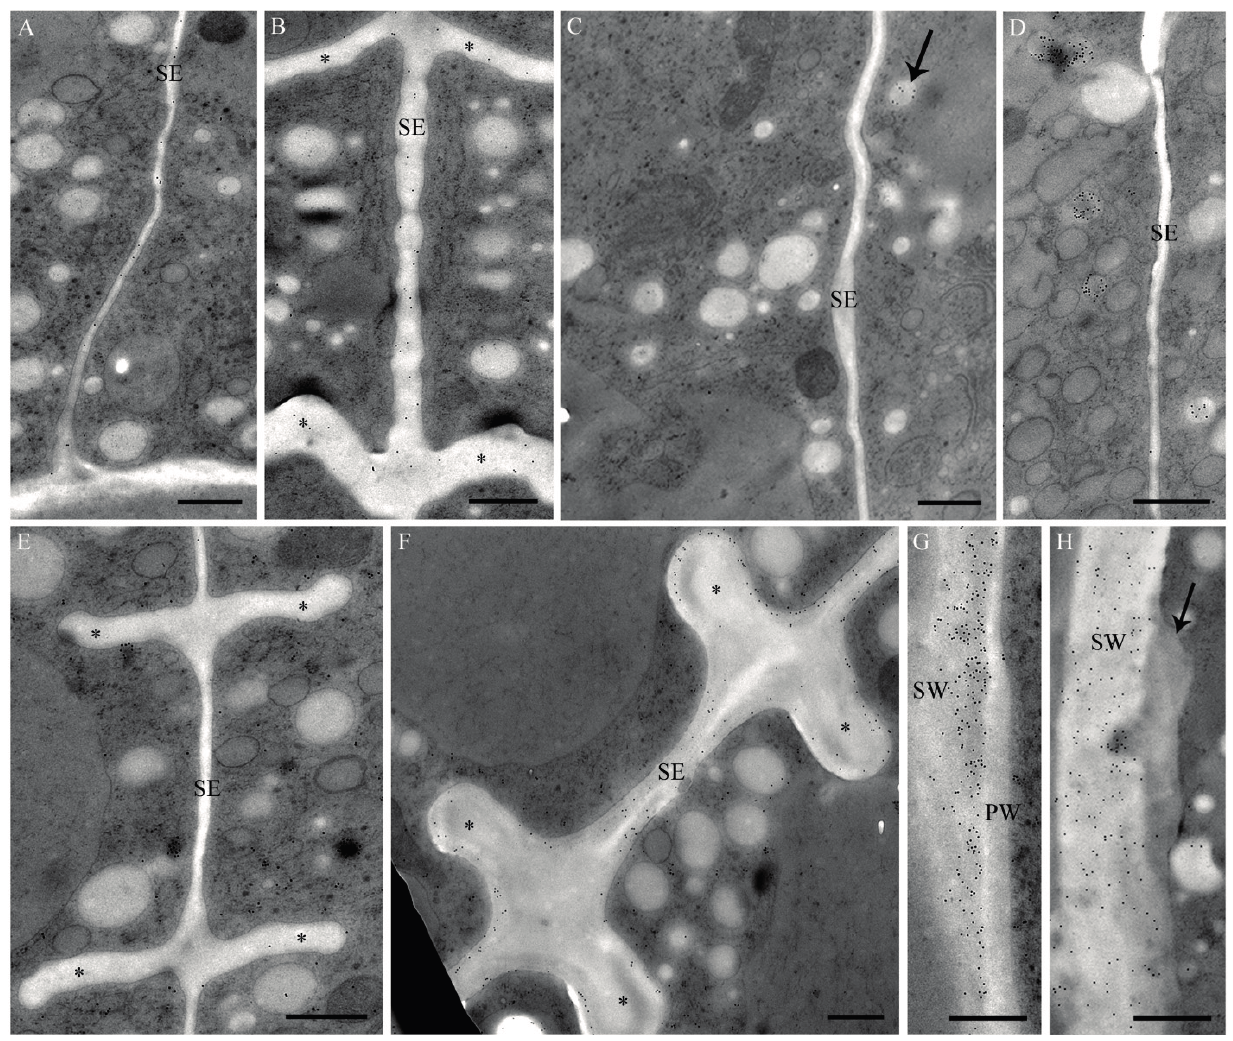
Figure 3. ( A – D ) Immunogold labeling with different JIM antibodies during cell wall formation in Desmidium ; and ( E – H ) immunogold labeling with BG1 (cross sections). ( A ) At an early stage the thin septum is labeled by JIM 5; ( B ) In a subsequent stage septum and newly-formed cell wall cylinders (asterisks) are labeled by JIM 7; ( C ) A particular population of vesicles in the area of the septum is slightly stained by JIM 8 (arrow). No staining of the septum by JIM 8; ( D ) Particular vesicle population stained by JIM 13. No staining of the septum by JIM 13; ( E ) Septum and cell wall cylinders (asterisks) in an early developmental stage. No labeling of the primary wall by BG1; ( F ) Septum and cell wall cylinders (asterisks) in a later developmental stage. The secondary wall is clearly labeled by BG1, the central part, consisting of the primary wall, remains unstained; ( G ) Newly-formed primary wall in the isthmus with adjacent secondary wall. The secondary wall is strongly labeled by BG1, the primary wall remains unstained; ( H ) Secondary wall of a ZnSO 4 -treated cell with abnormal depositions (arrow). The secondary wall is labeled by BG1, the abnormal deposition not. PW: Primary wall; SE: Septum; SW: Secondary wall. Bar = 0.5